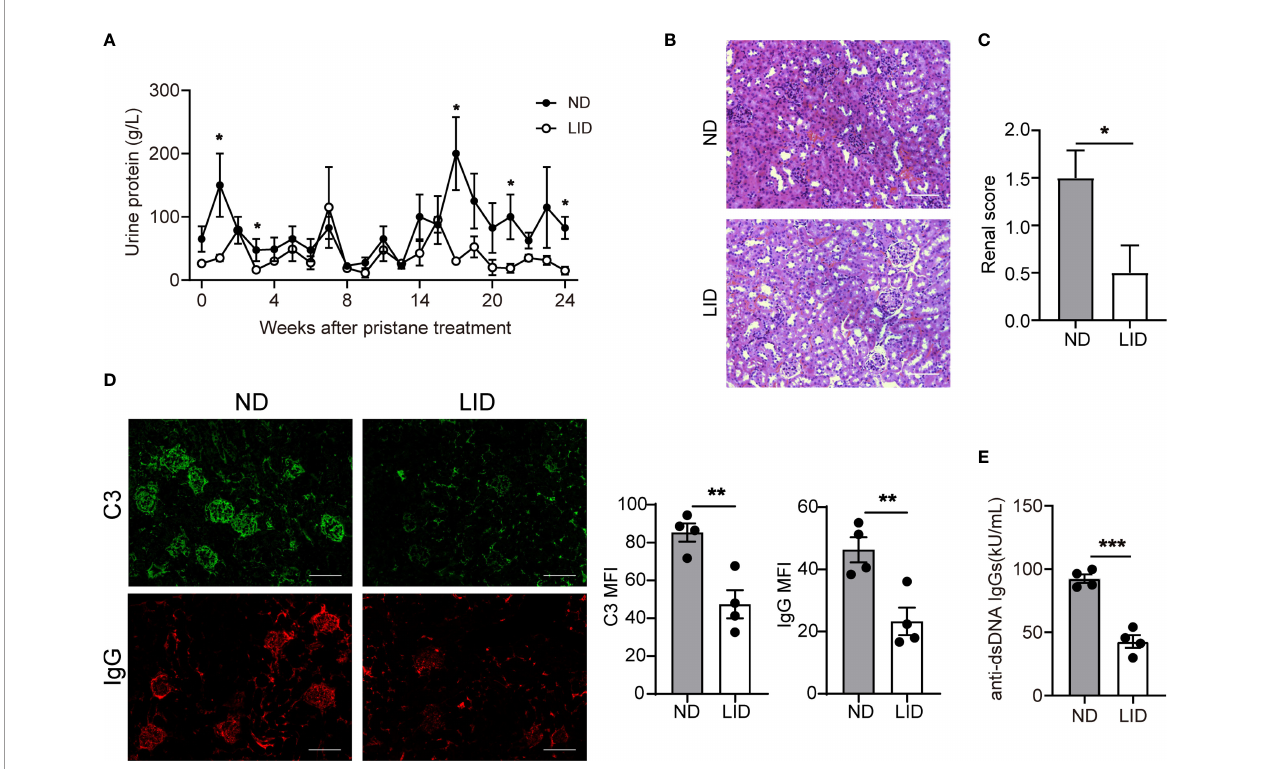
FIGURE 2 | Insuf fi cient iron improves the disease progression of pristane-induced lupus. 8-weeks old female mice were i.p. injected with 500 m l pristane and fed with ND or LID for 6 months. After 6-months of pristane stimulation, mice were sacri fi ced for analysis. (A) Urine protein levels of ND- and LID-treated mice. (B) Representative morphology of the renal tissues by H&E staining. Scale bar, 100 m m. (C) Histological scoring of the renal tissues in (B). (D) Representative immuno fl uorescent staining and quanti fi cation of C3 and IgG in kidney after 6-months of pristane stimulation. Green, C3; Red, IgG. Scale bar, 100 m m. (E) Serum level of anti-dsDNA IgGs after 6-months of pristane stimulation. ***P < 0.001, **P < 0.01, *P < 0.05 (unpaired two-tailed Mann-Whitney U tests for A, C ; unpaired two-tailed Student ’ s t -test for D, E ). Data are shown as mean ± S.E.M. Two independent experiments were performed, n =